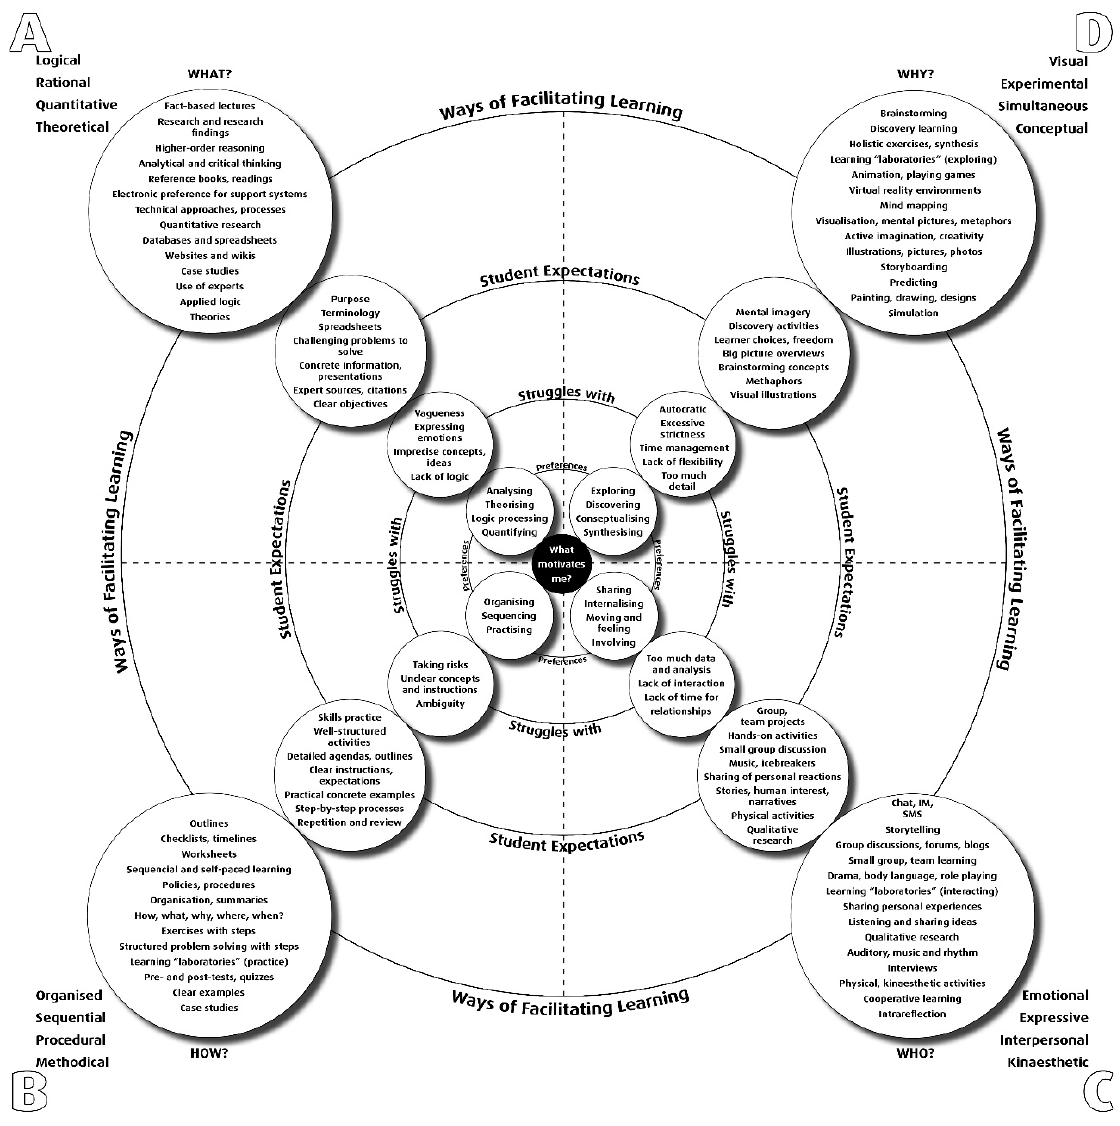
Figure 1: Comprehensive whole brain ® model (De Boer et al.